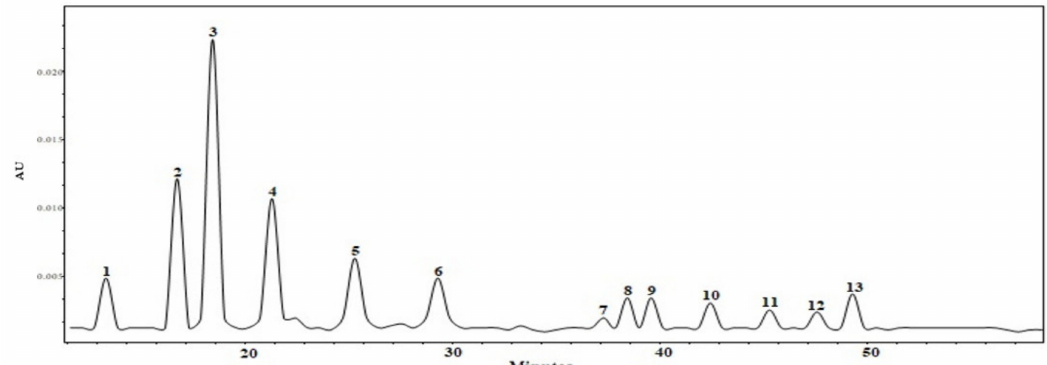
Figure 3. HPLC chromatogram of the dry ethanol extract of apple (AEW). Analytes determined at a λ = 280 nm wavelength: 1—procyanidin B1; 2—(+)-catechin; 3—chlorogenic acid; 4—procyanidin B2; 5—( − )-epicatechin; 6—procyanidin C1; at a λ = 360 nm wavelength: 7—rutin; 8—hyperoside; 9—isoquercitrin; 10—reynoutrin; 11—avicularin; 12—quercitrin; at a λ = 280 wavelength: